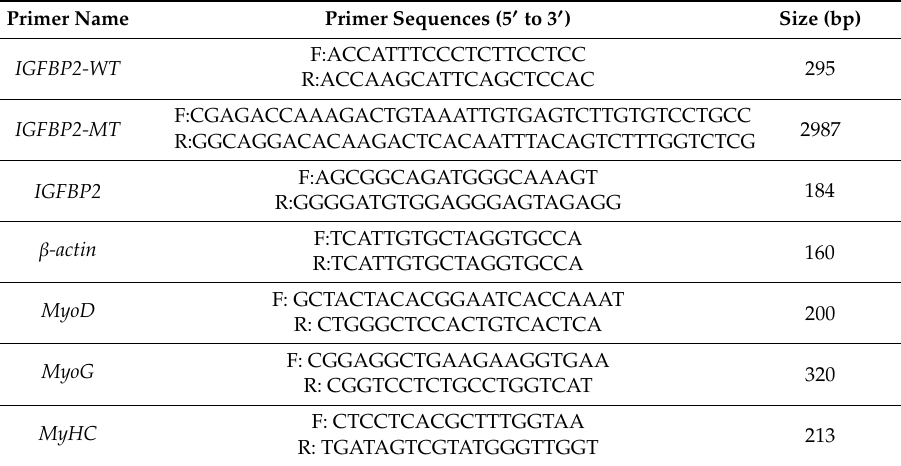
Table 2. Primers used in this